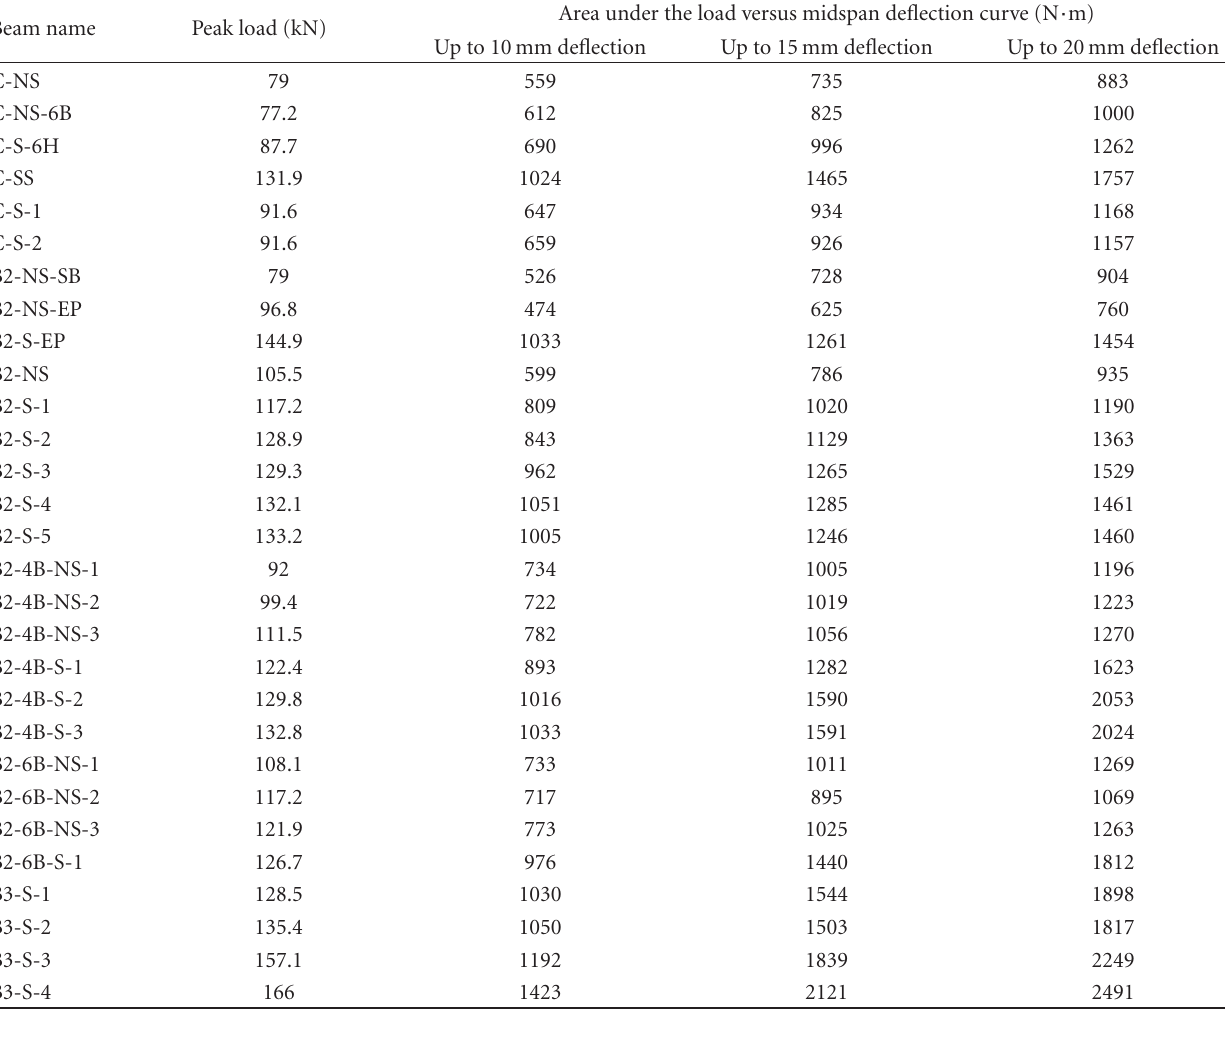
Table 3: Peak loads and area under the load versus midspan deflection curves of RC beams.